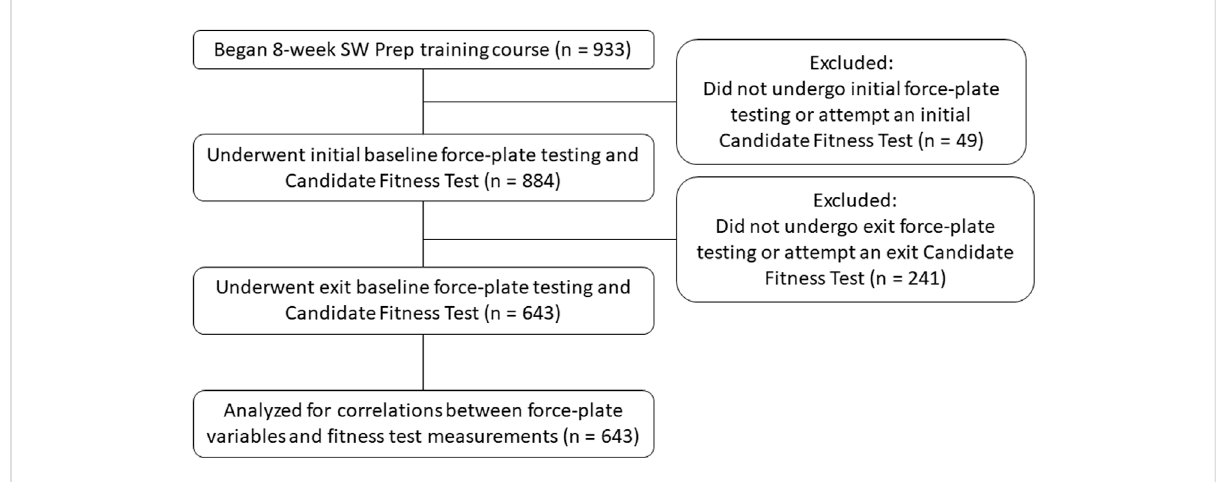
FIGURE 1 Flowchart accounting for subject participation and those lost to follow up. SW Prep = Special Warfare Preparatory Course.